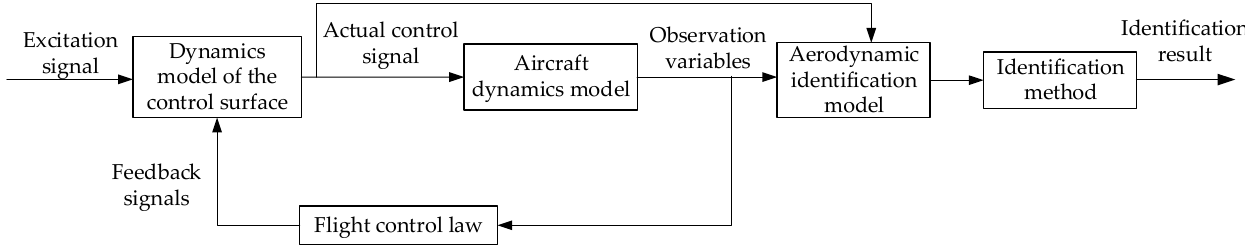
Figure 6. Principle of excitation signal action.